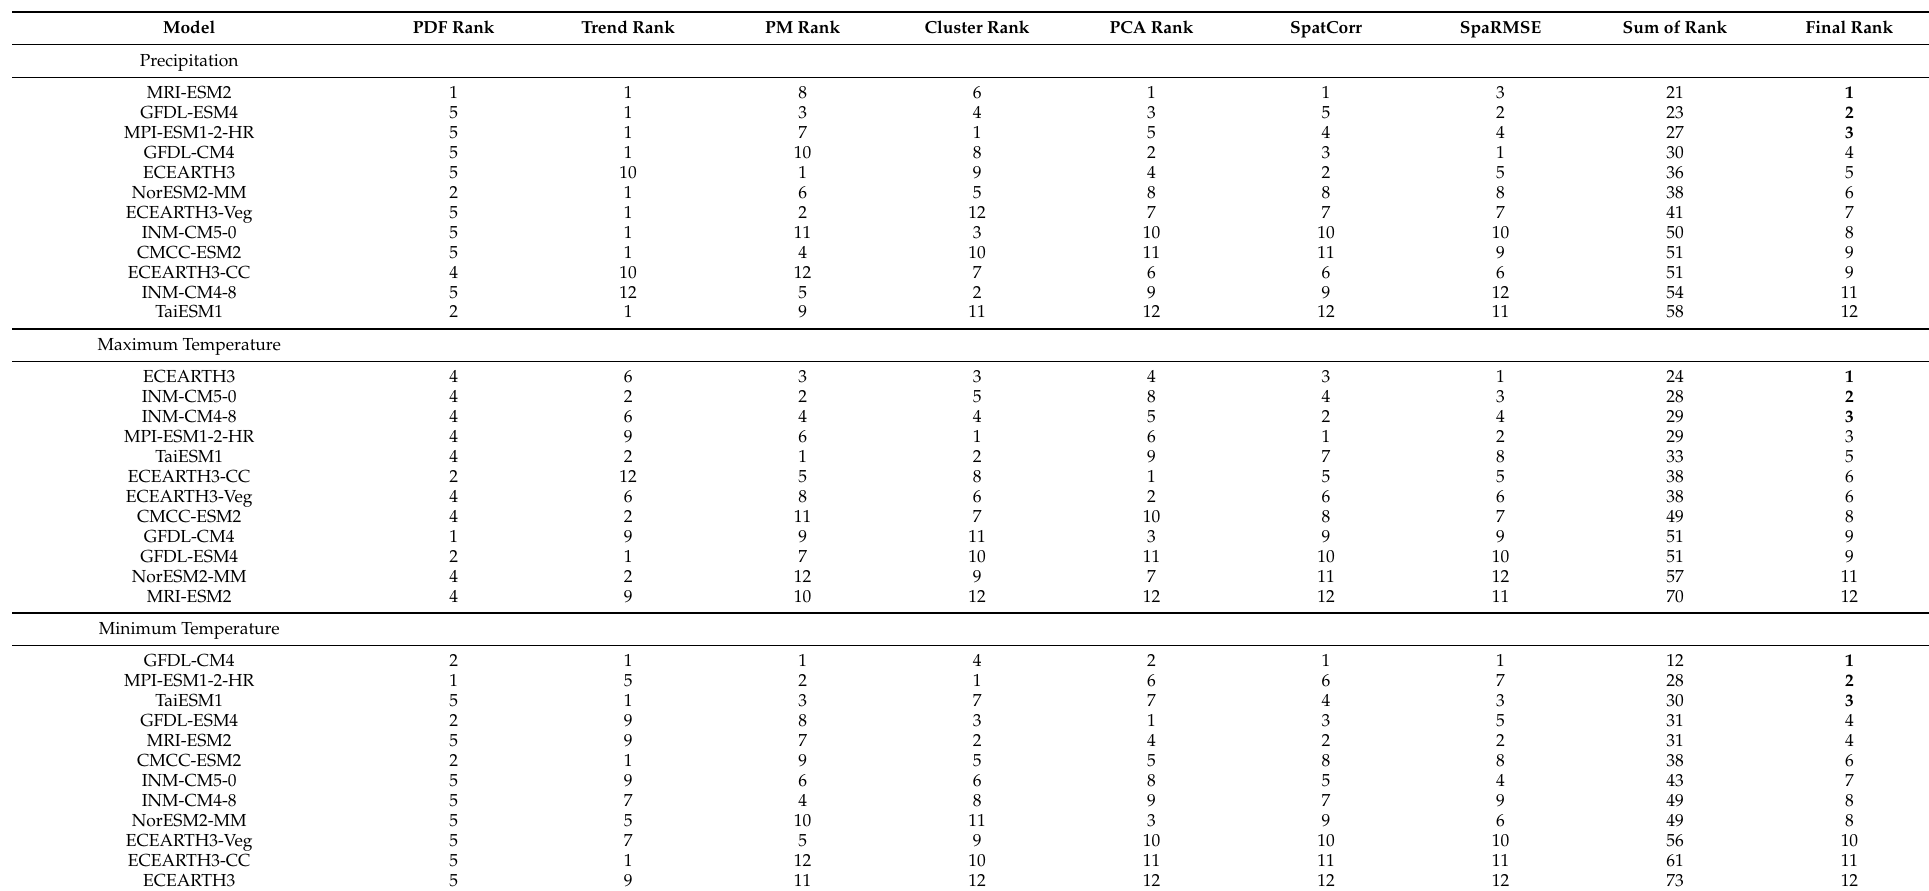
Table 6. Summary rank based on seven criteria used for evaluating the three climate model time